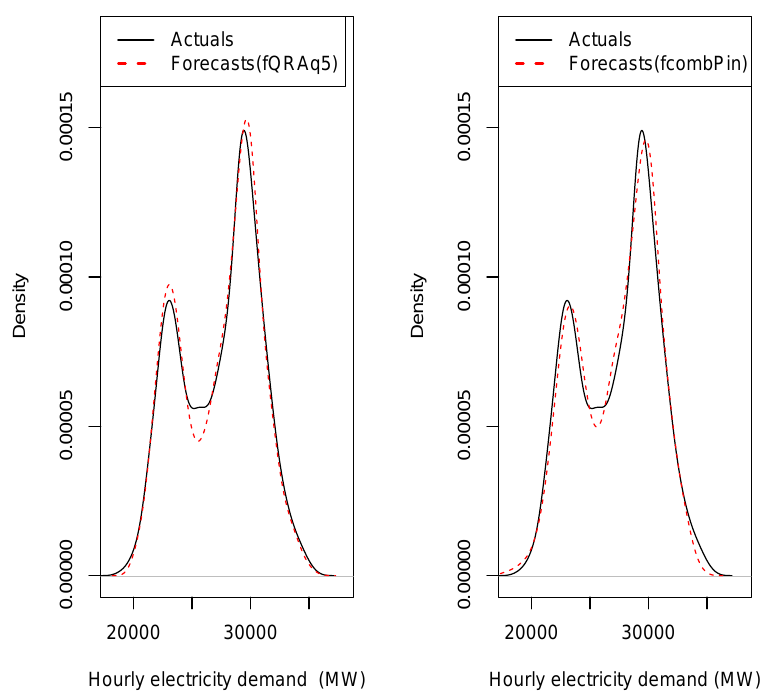
Figure 10. Density plots of actual demand superimposed with density plots from M 6 and M 5 models (2 April to 31 December